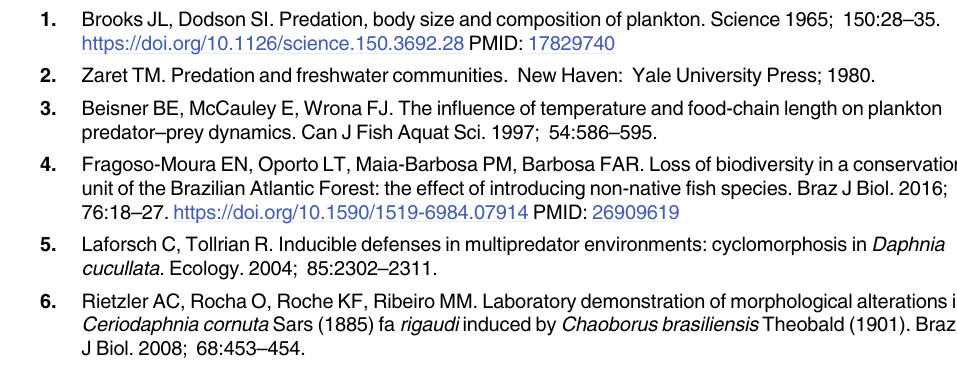
S2 Fig. Somatic growth of Mesostoma ehrenbergii (A) and Mesostoma craci (B) at different temperatures (20, 24 and 28˚C) and prey densities during 10 days, including initial, mid and final measurements (filled circles, squares and triangles correspond to 2, 5 and 10 prey, respec- tively). (TIFF) S3 Fig. Proportion of resting eggs at different temperatures and ad libitum feeding (A) and total number of eggs produced at different prey densities (B) in Mesostoma ehrenbergii . Open and filled bars correspond to subitaneous and resting eggs, respectively. (TIF) S1 Table. Statistical results (p-values, F and R2) of the linear mixed-effects models for Mesostoma ehrenbergii and Mesostoma craci . Na: not available. (TIF) S2 Table. Predation rates of Mesostoma craci on Daphnia similis (present study) and on Ceriodaphnia silvestrii (additional experiment) during 3 days, and a comparative statistical analysis.